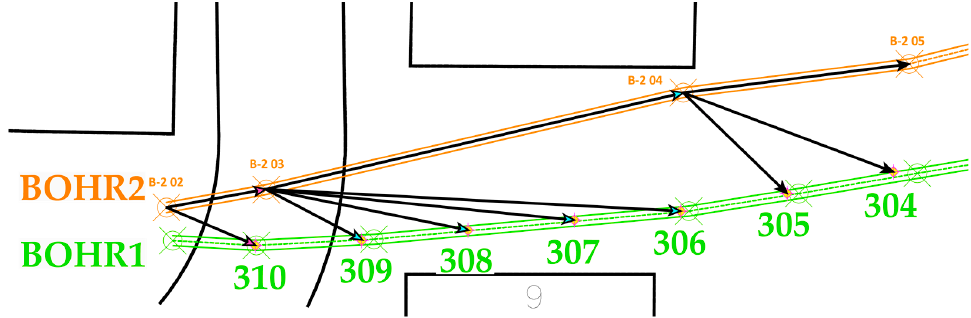
Figure 8. Flow schematic and dimensions for model validation. April 15th was the start date of the 5-month charging period for the BTES system in all modeled configurations except for the single-bore validation model. Heat produced with a heating cell was transferred during an 8-h period between 11:00 and 19:00. These hours were chosen for having the highest temperatures during the day with significant sunlight. Weather parameters used in this study were sourced from Meteonorm [24]. Fig- ure 9 shows the distribution of daily temperatures relative to the hourly average temper- ature during the charging phase. A normalized ambient temperature (𝑁𝐴𝑇) of 1 refers to an hourly average temperature equal to the charging period average. A NAT < 1 indicates a cooler-than-average charging period temperature, and NAT > 1 indicates a warmer- than-average temperature. In addition, the curves depicting solar elevation angle are overlaid to give a sense of PV potential during the daily BTES system charge times. Sym- bols with a black field are charging months before the summer equinox, and those with a black fill are months after the equinox. Figure 9. Normalized ambient temperature during the charging period. The simplification of straightening the heated borehole (BOHR2) required an adjust- ment of the sensor positions. Vectors for linear segments defined by global positioning system (GPS) waypoints on BOHR2–BOHR6 and vectors for temperature sensors along each segment were used to determine sensor locations relative to the heated borehole in 3 dimensions. Measurement data in borehole Figure 10 below show how this process works in 2 dimensions.